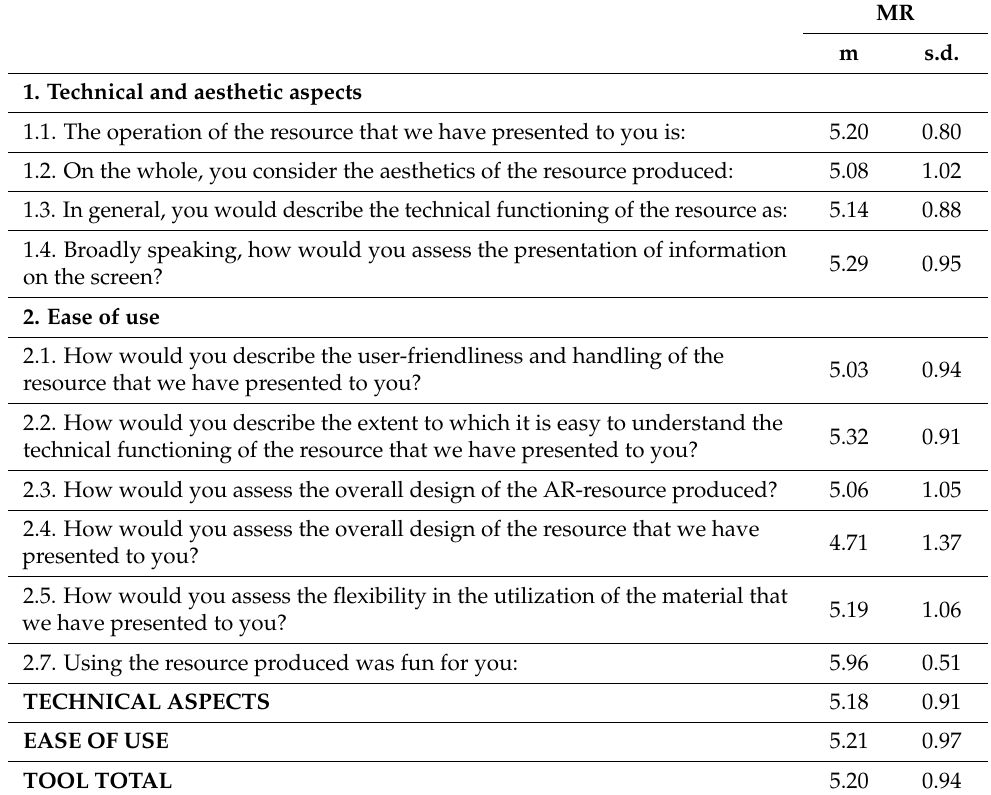
Table 5. Means and standard deviations obtained with the tool used to evaluate the object